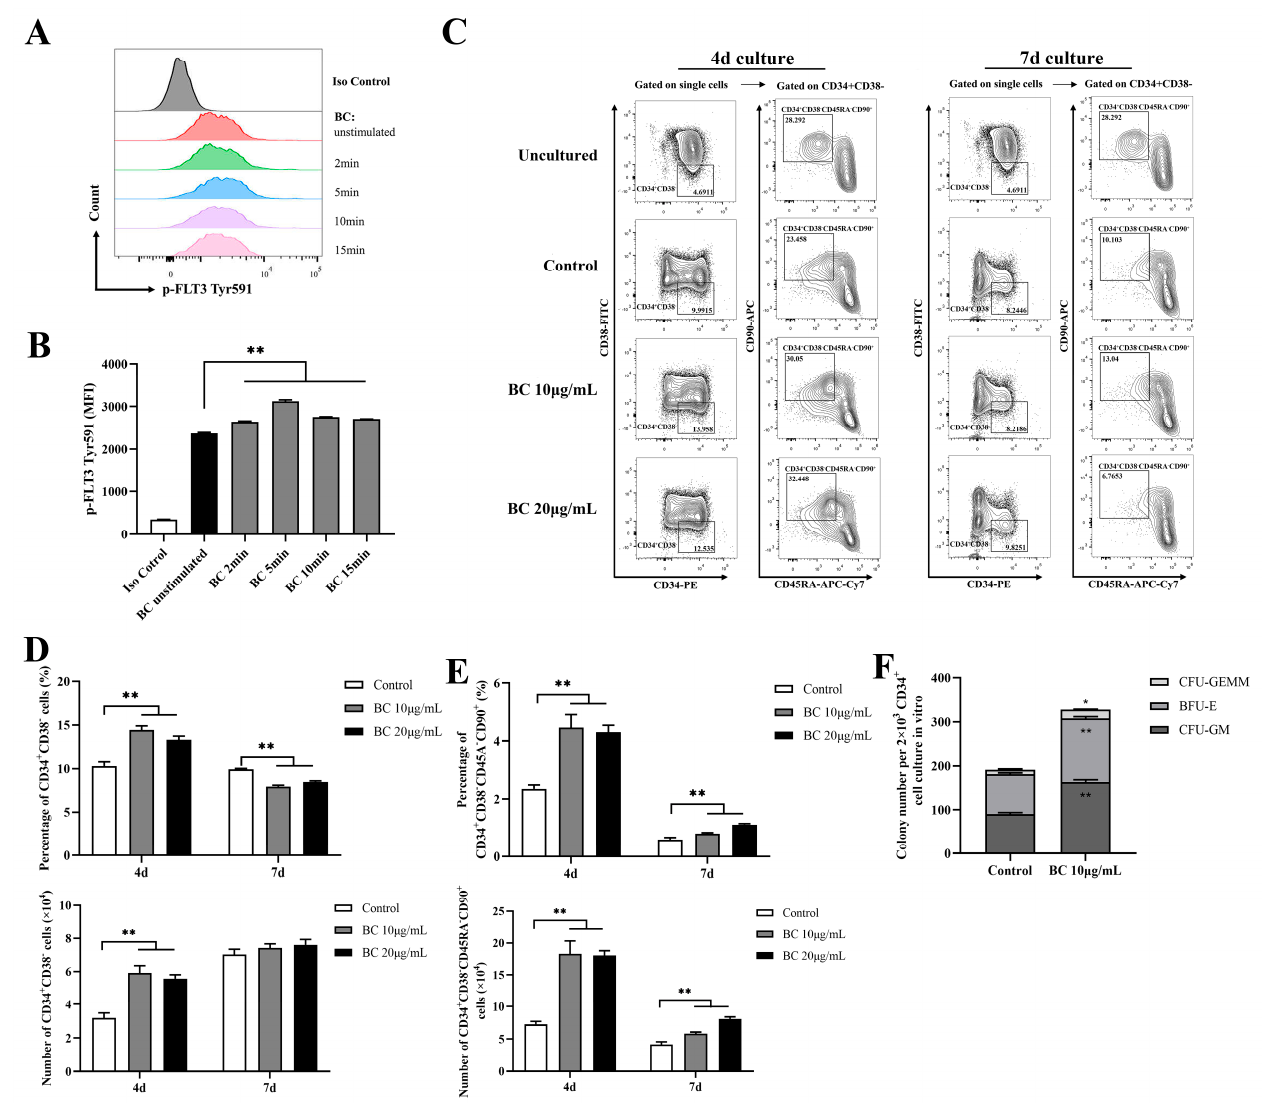
Figure 4. BC increases the proportion of primitive HSC population and colony − forming ability of human CD34 + cord blood cells in vitro . ( A , B ) Flow cytometry analysis of FLT3 phosphorylation in CD34 + UCB cells cultured in vitro with or without BC (10 μ g/mL) treatment for 2 − 15 min. ( A ) Flow cytometry histogram showing the intensity of p − FLT3 Tyr591 versus cell counts. ( B ) The mean fluorescence intensity (MFI) analysis of p − FLT3 Tyr591 from three independent experiments. ( C ) Representative flow cytometry profiles to show the percentage of CD34 + CD38 - and CD34 + CD38 - CD45RA - CD90 + cells in CD34 + UCB cells cultured in vitro with or without BC treatment for 4 days or 7 days. Gates shown identify the CD34 + CD38 - and CD34 + CD38 - CD45RA - CD90 + populations from CD34 + cells. ( D , E ) The proportion and absolute number of CD34 + CD38 - and CD34 + CD38 - CD45RA - CD90 + cells in ( C ). Data represent three independent experiments. ( F ) Colony counting of HSPCs derived CFUs from 2 × 10 3 CD34 + UCB cells cultured in vitro with or without BC treatment for 7 days. Data represent triplicate experiments. All data error bars are shown as mean ± SEM, * p < 0.05, ** p < 0.01 (Student’s t test).